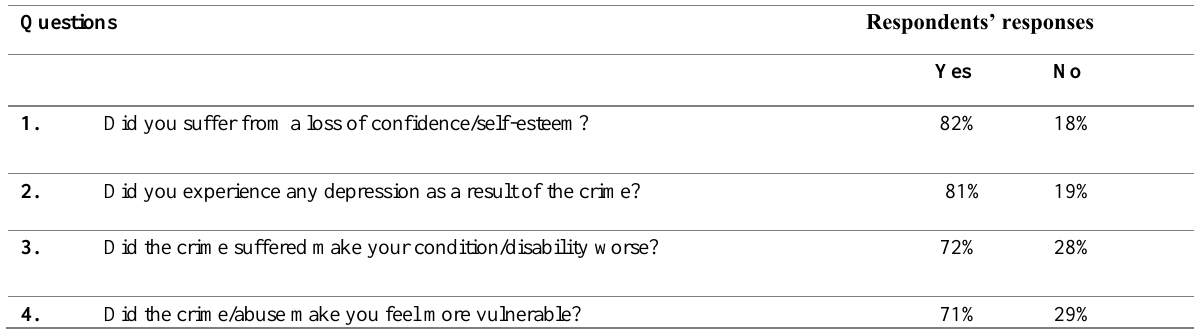
Table 1: The Impact of Abuse/Crime Committed Against Physically Disabled